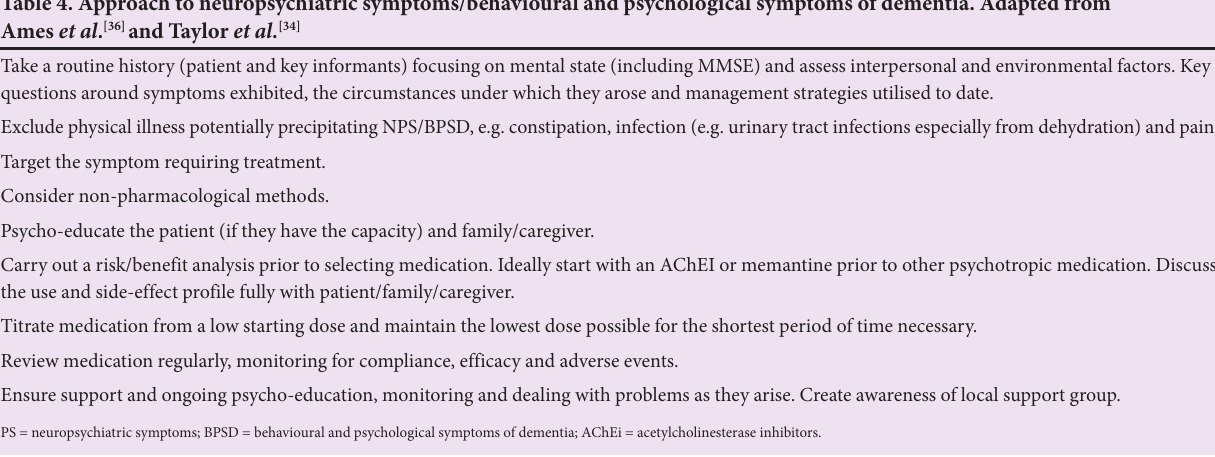
Table 4. Approach to neuropsychiatric symptoms/behavioural and psychological symptoms of dementia. Adapted from Ames et al . [36] and Taylor et al.